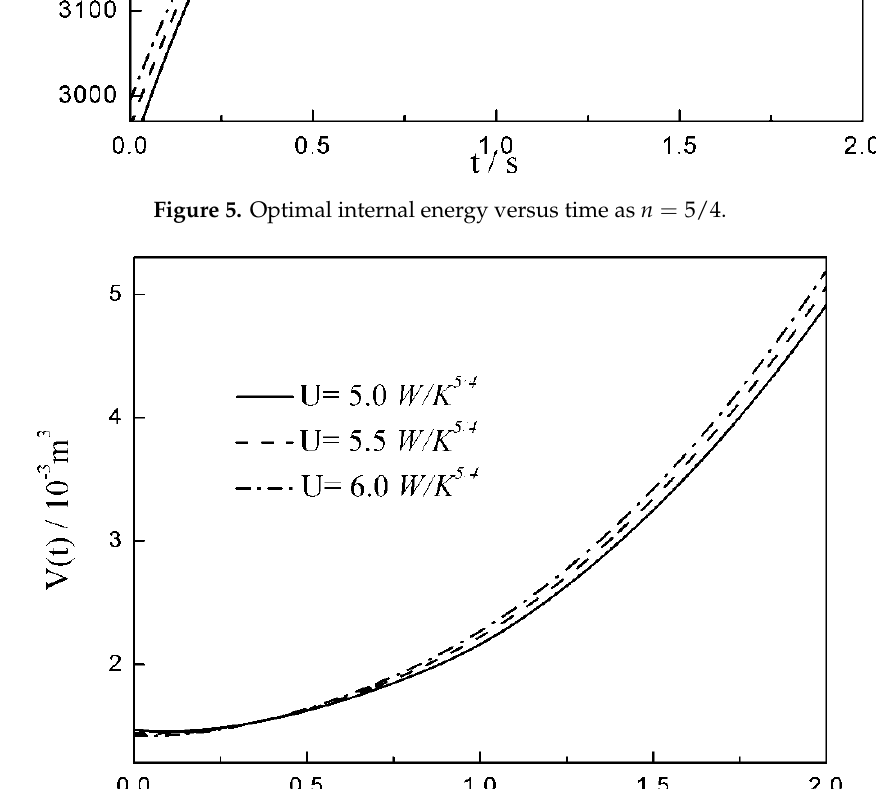
Figure 6. Optimal volume versus time as 5 4 n = .